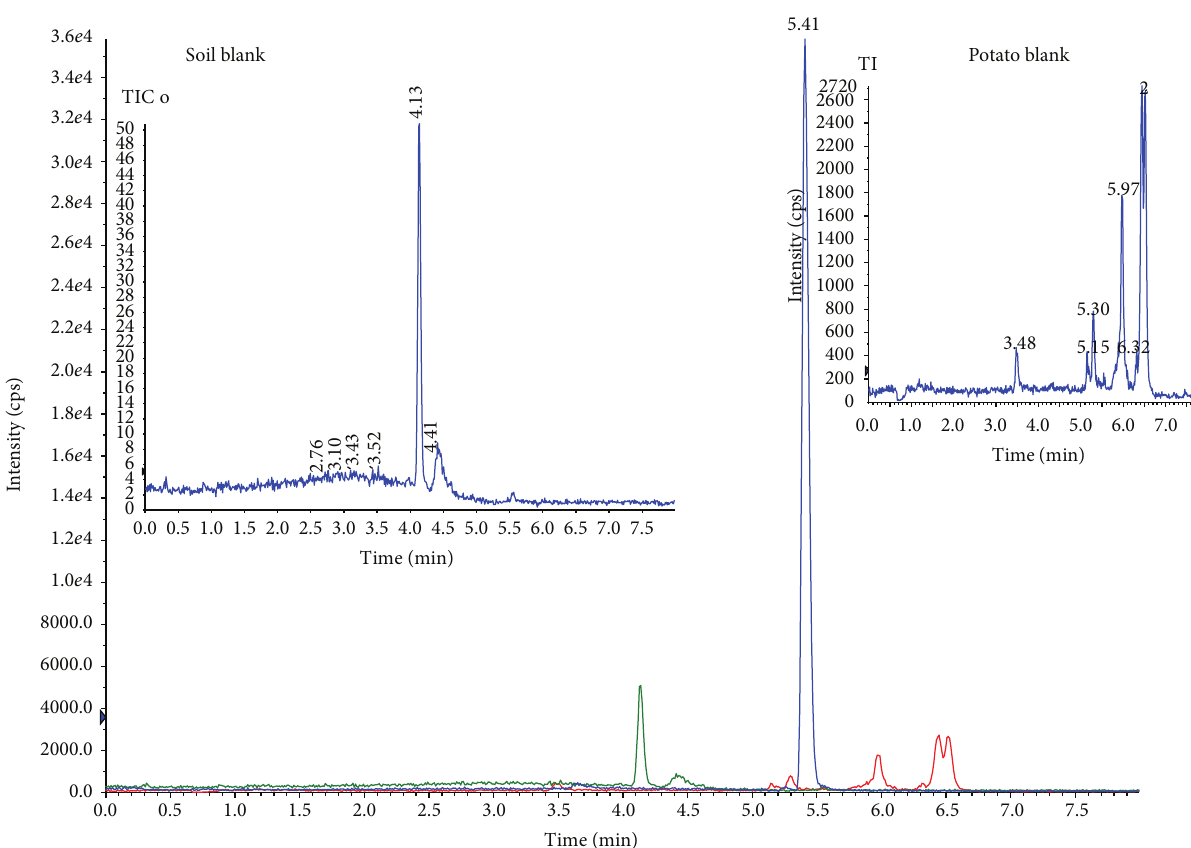
Figure 2: Multiple reaction monitor (MRM) chromatograms of paclobutrazol fortified and potato blank and soil blank in quantitative ion, 𝑡 = 5.41 min